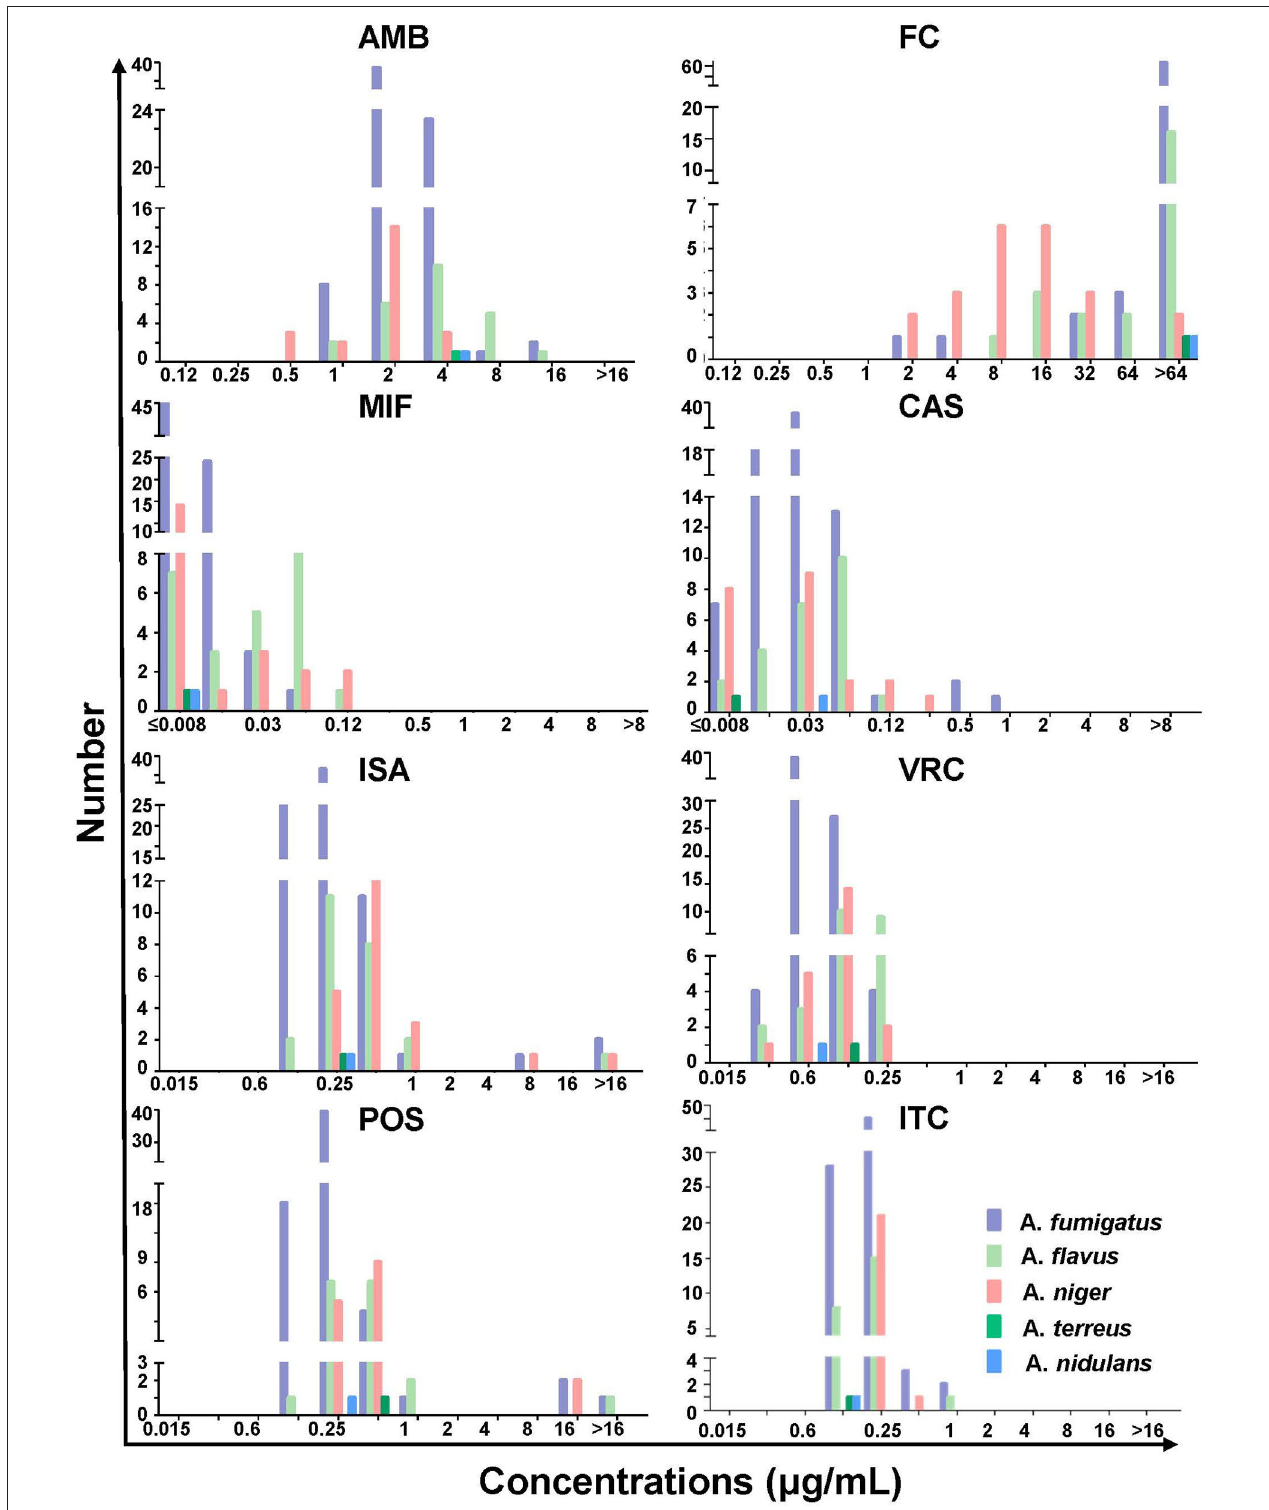
FIGURE 4 | The minimum inhibitory or effective concentration distribution of amphotericin B (AMB), flucytosine (FC), micafungin (MIF), caspofungin (CAS), isavuconazole (ISA), voriconazole (VRC), posaconazole (POS), and itraconazole (ITR) for the indicated Aspergillus spp.